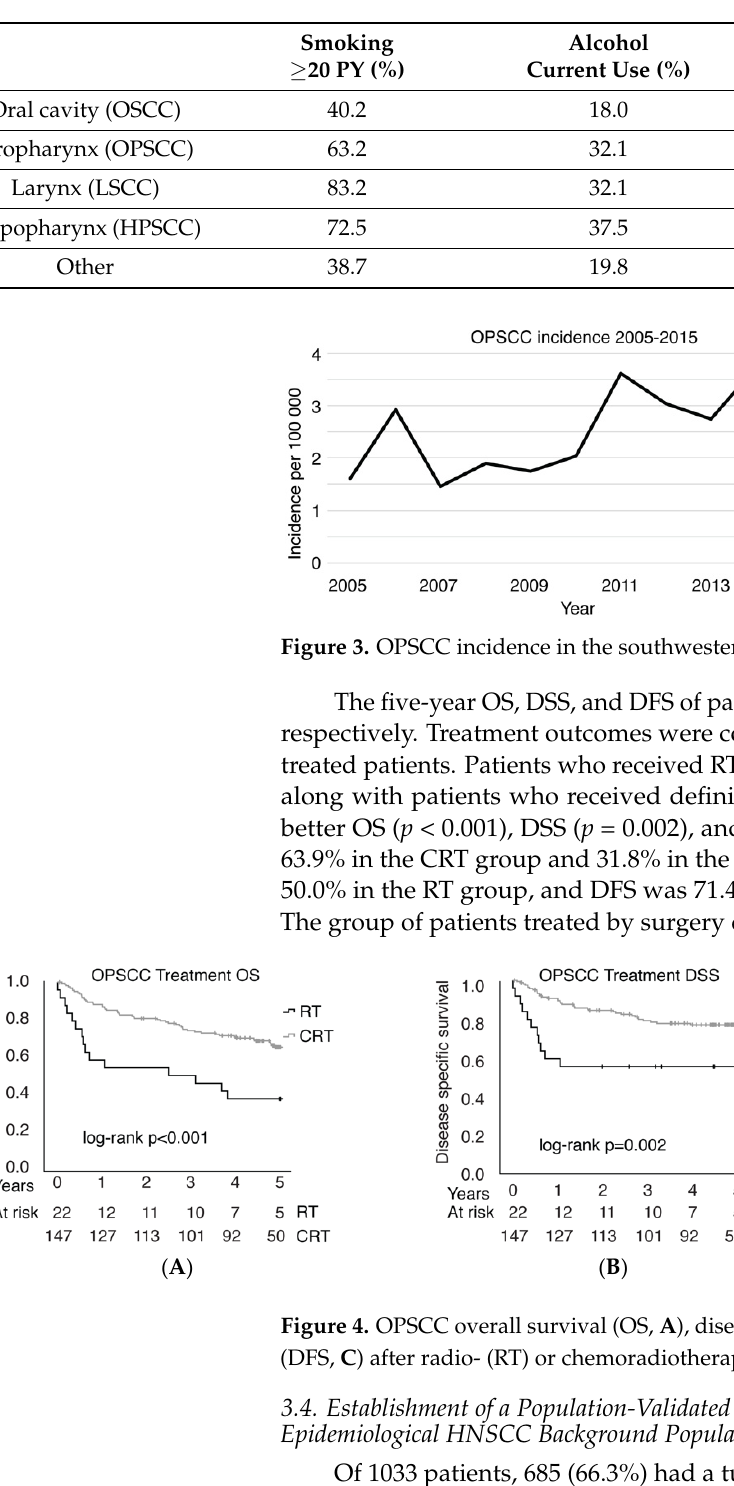
Of 1033 patients, 685 (66.3%) had a tumor sample available for PV-TMA, as shown in Figure 1. Clinical data of TMA patients were compared to the background population of all HNSCC patients treated in the Southwest Finland region from 2005–2015. The repre- Figure 4. OPSCC overall survival (OS, A ), disease-specific survival (DSS, B ) and disease-free sur- sentativeness of the TMA cohort against the background HNSCC population is presented vival (DFS, C ) after radio- (RT) or chemoradiotherapy (CRT). in Table 3. The established TMA was confirmed to be representative in terms of age, sex, alcohol and tobacco consumption, T-class, and stage, while an uneven distribution